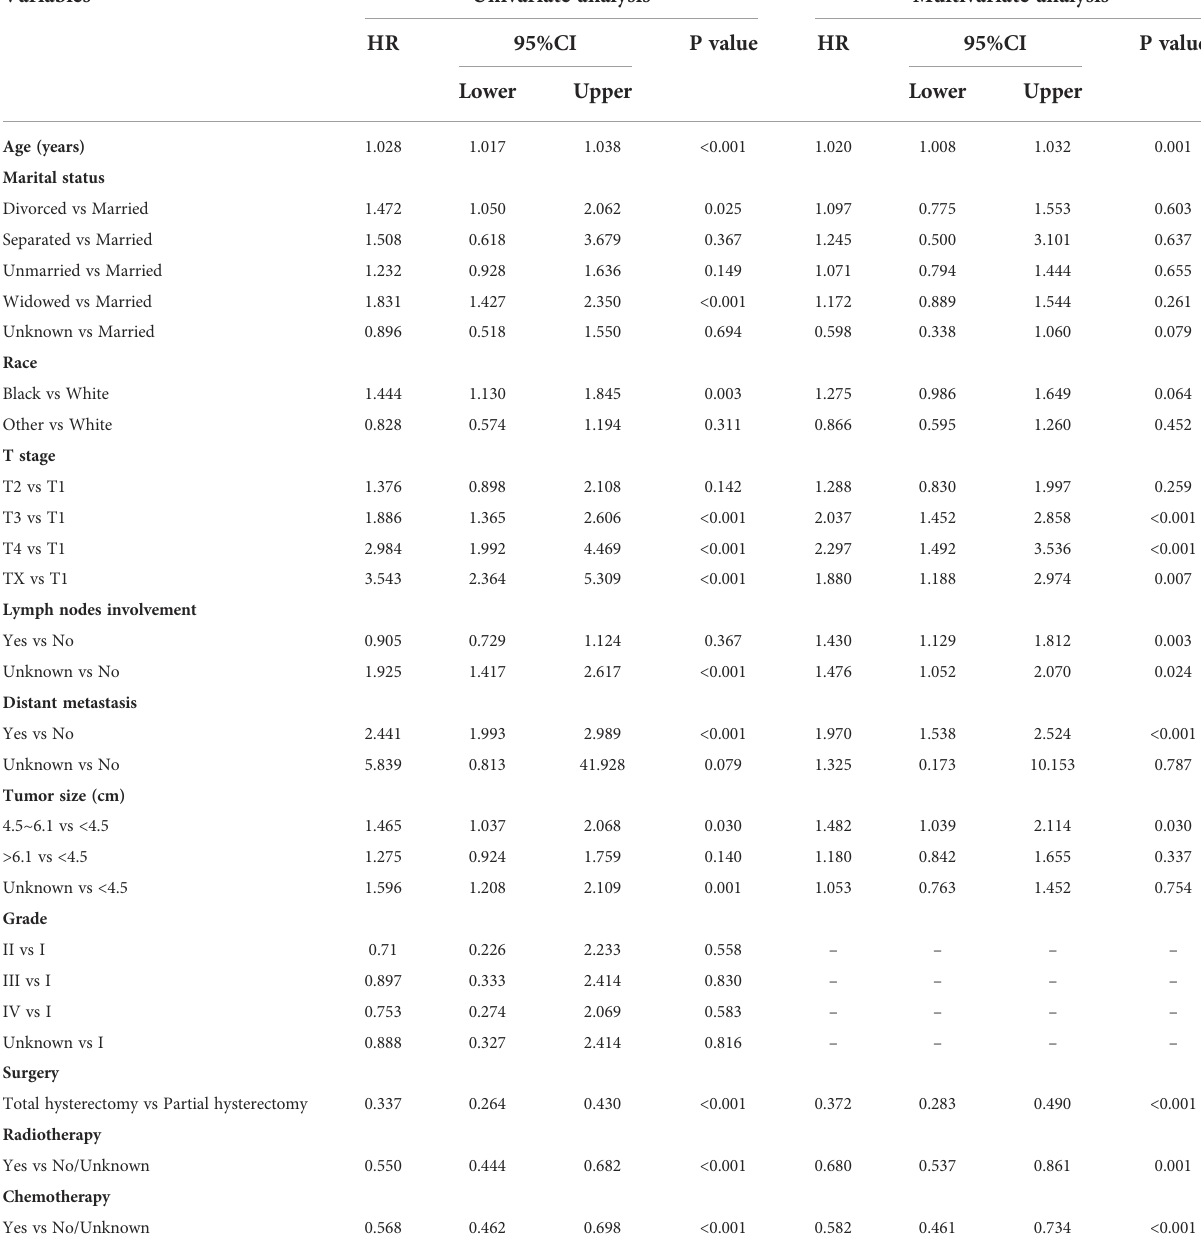
TABLE 3 Univariate and multivariate COX analyses of OS in the FIGO stage III/IV training